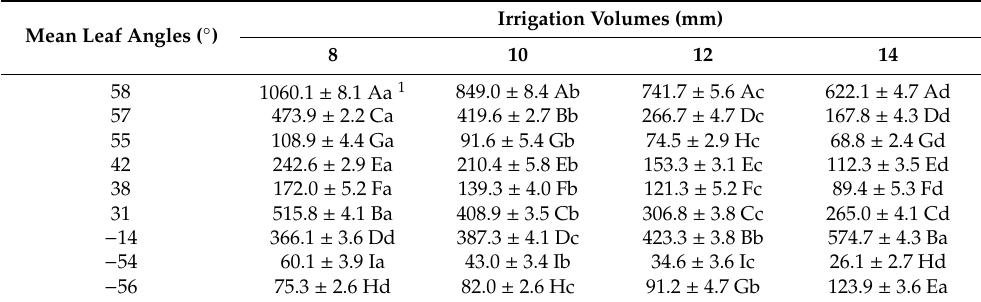
Table 2. E ff ect of interaction between mean leaf angle and irrigation volume on the crown projection area (cm 2 ) of seedlings (mean ± standard